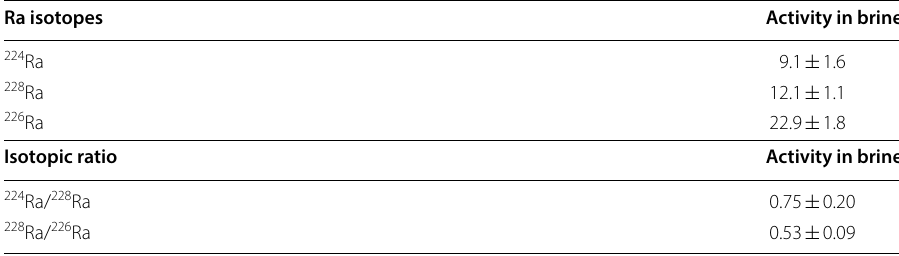
Table 6 Radium activities (Bq kg − 1 ) and their ratios measured in August 1986 from a brine sample collected from GB2 production